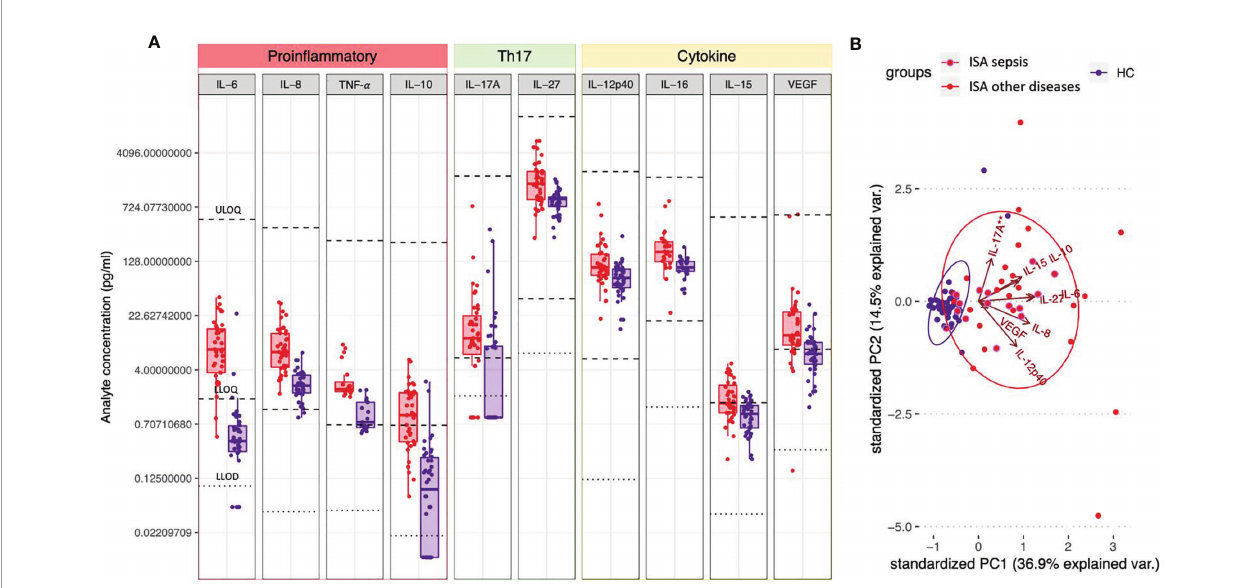
FIGURE 2 | Circulating cytokines de fi ning a S. aureus invasive disease signature. (A) Plasma or serum samples obtained from patients with invasive S. aureus disease (ISA, in red) or from healthy controls (HC, in purple) were tested for the presence of cytokines/chemokines by 36-V-PLEX assay. Individual concentrations are represented as dots. Boxplots represent fi rst and third quartile; median, minimum and maximum values are also shown. For each analyte light dotted lines represent lower limits of detection (LLOD) and bold dotted lines represent upper and lower limits of quanti fi cation (ULOQ and LLOQ). Concentrations below detection or fi t curve range were assigned a concentration corresponding to ½ LLOD. Analytes ’ concentrations detected in ISA vs . HC were compared by Dunn ’ s post-test after Kruskal-Wallis non-parametric test. Only analytes for which P<0.05 and at least the median of one of the two groups analyzed was in the quanti fi cation range are shown. (B) Principal Component Analysis (PCA) of the cytokines shown in A. Red dots and ellipses refer to ISA while blue ones refer to HC. Among the ISA samples (in red), the sub-group relating to patients with sepsis are circled in purple. Arrows reveal how each cytokine contributed to the PCA plotted in the